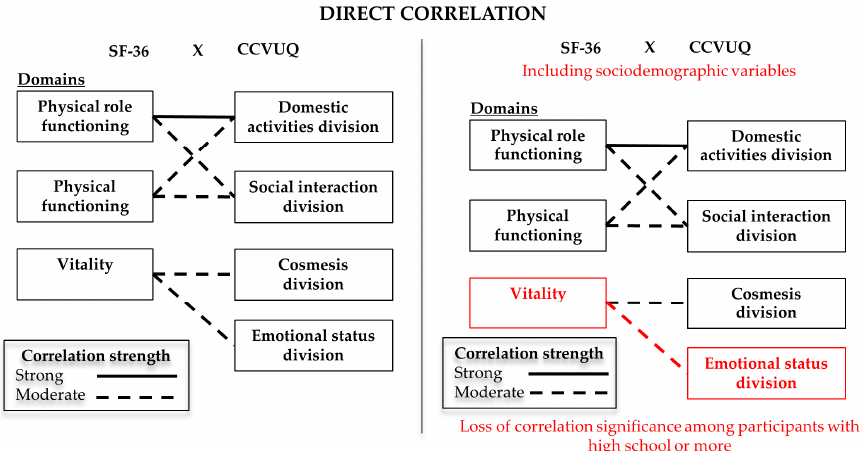
Figure 2. Graphical representation of the direct correlations between the SF-36 and CCVUQ scales.